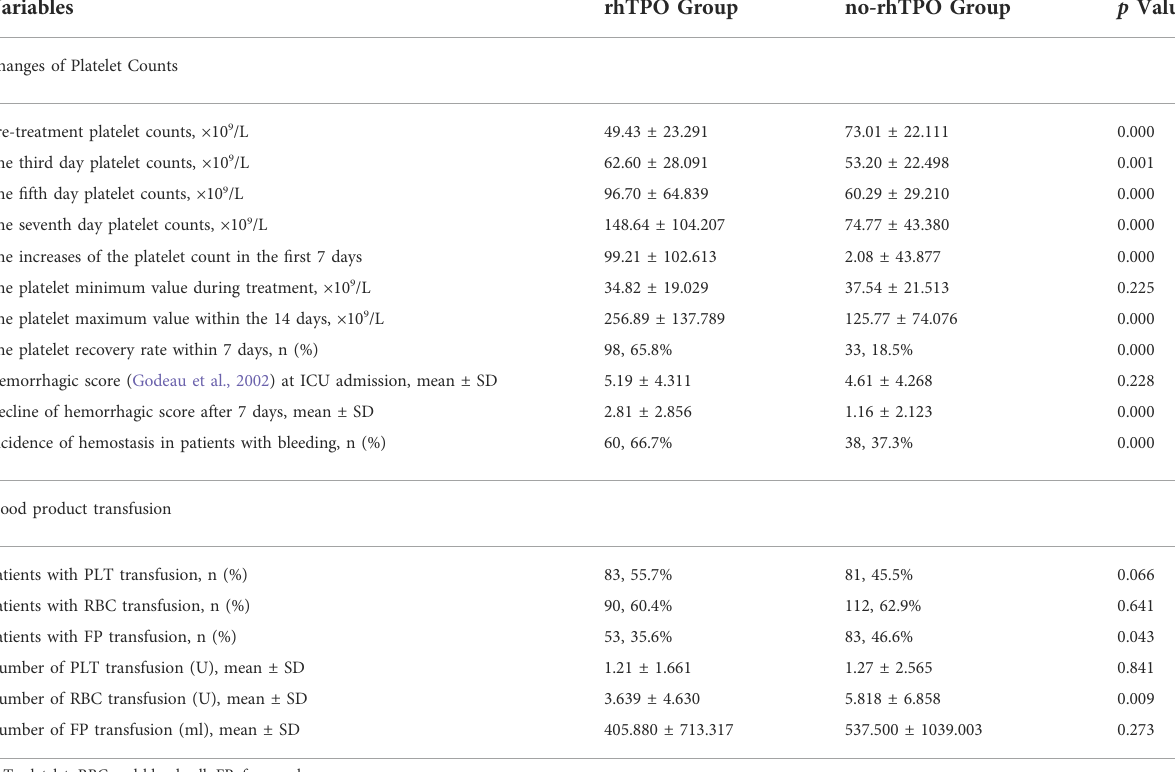
TABLE 2 Platelet counts and therapeutic effects.